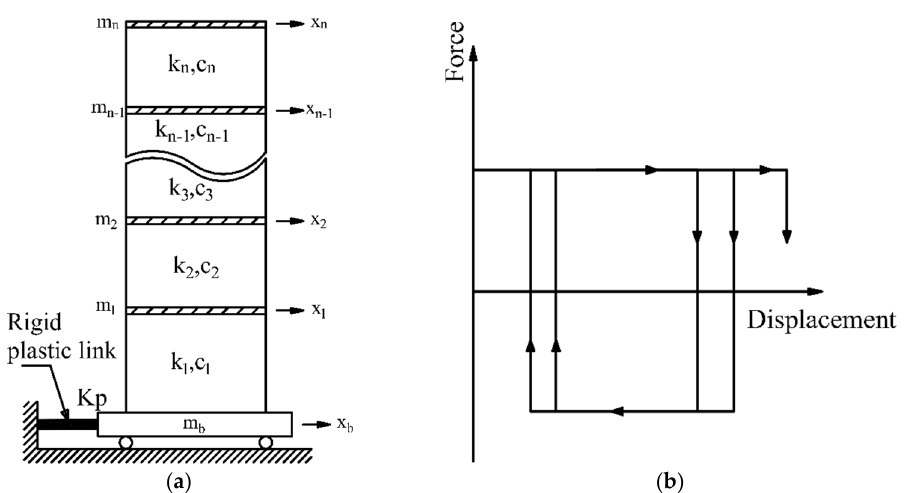
Figure 12. Structure considered by Vafai et al. [33]. ( a ) MDOF system with fictitious spring, ( b ) force- displacement behavior of rigid plastic link.